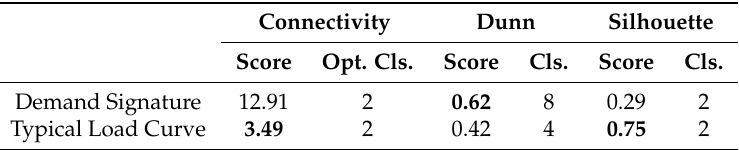
Table 6. Optimal segmentation based on the internal cluster validation.